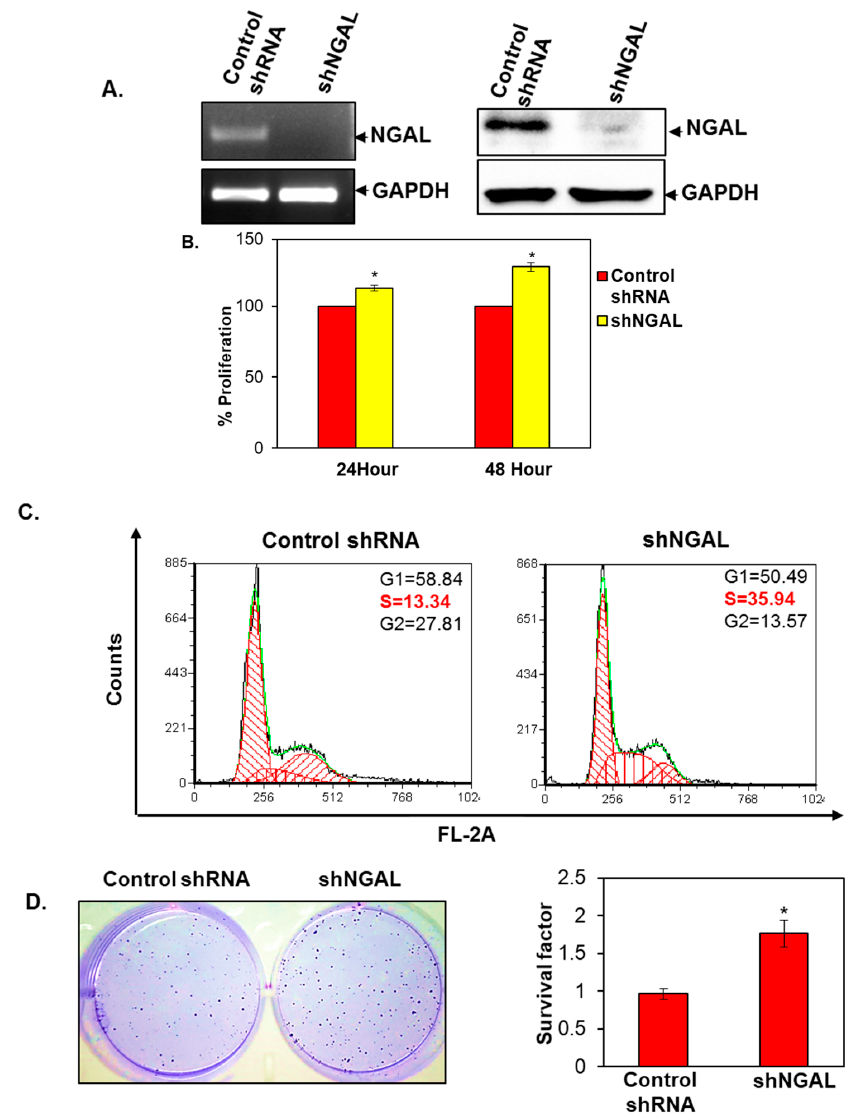
Figure 3. Silencing of NGAL in oral cancer cells. ( A ) qRT–PCR showing the mRNA expression of NGAL in SAS cells post knockdown (left panel). Western blot analysis showing the expression of NGAL in SAS cells post knockdown (right panel). ( B ) Percentage increase in cell viability of